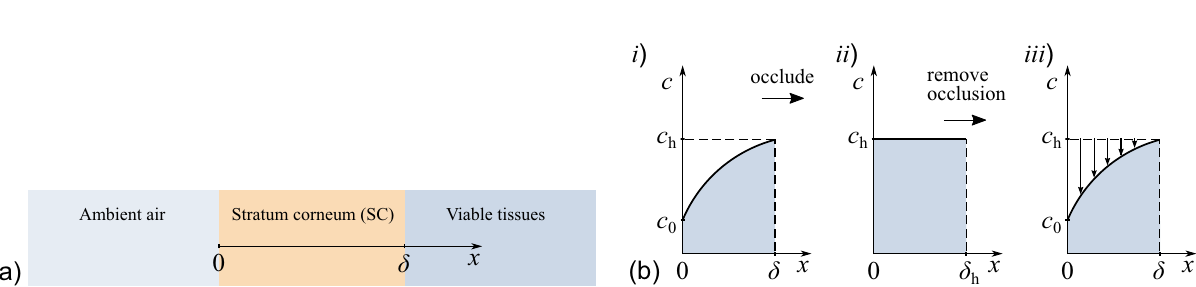
Figure 1. ( a ) Diffusivity of stratum corneum; ( b ) Mean diffusivity of stratum corneum. Curves 1, 2, and 3 correspond to formulas (1), (2), and (3), respectively.